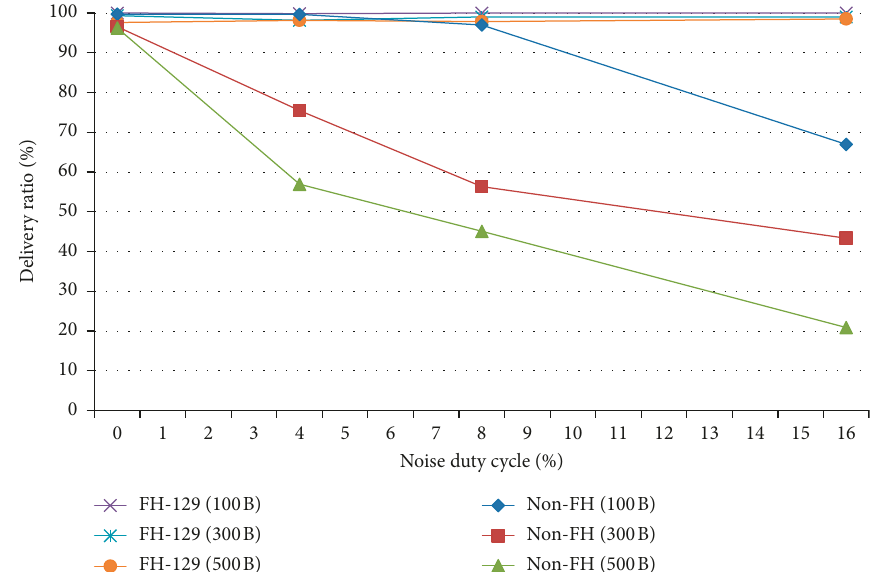
Figure 11: Delivery ratio as a function of noise duty cycle.